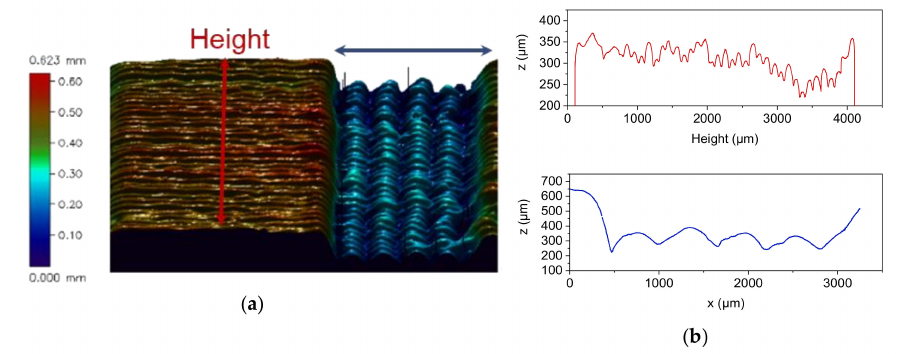
Figure 6. Surface topography analysis via white light interferometry: ( a ) 3D-surface scan and ( b ) upper image: profile of the structure´s sidewall quality along the red arrow, lower image: profile of the serrated structure along the blue